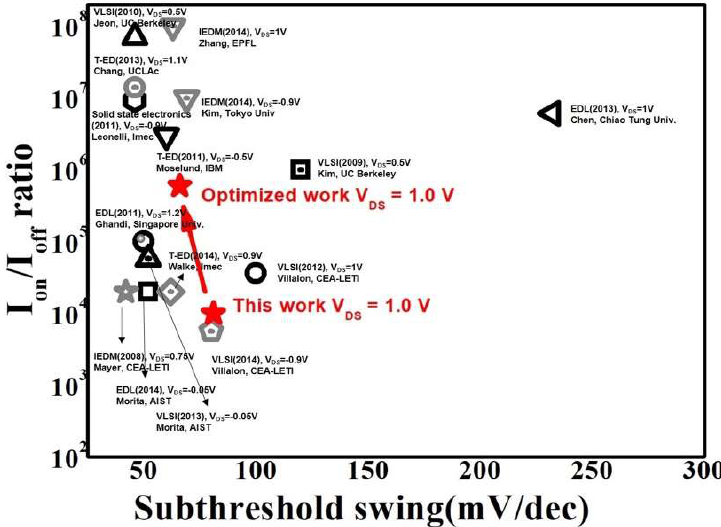
Figure 11. Performance comparison of TFETs. I ON / I OFF of TFETs as a function.